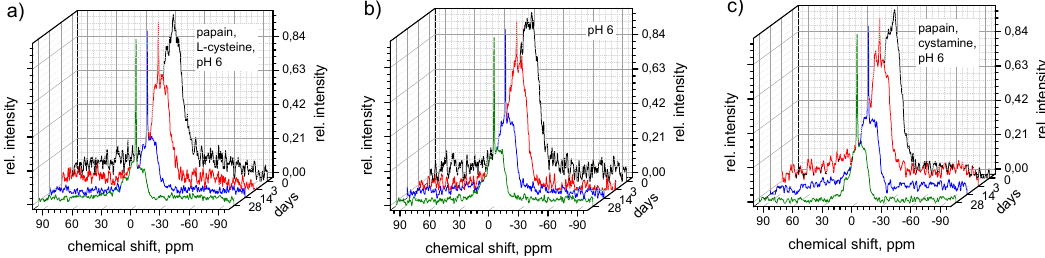
Figure 7. Enzymatic degradation of polymer 2 followed by 31 P NMR spectroscopy over 28 days in citrate buffer (pH6) containing L-cysteine and papain ( a ); hydrolytic degradation of polymer 2 in the same buffer system without papain ( b ); and with papain and cystamine as inhibitor ( c ). All samples were stored at 37 °C.